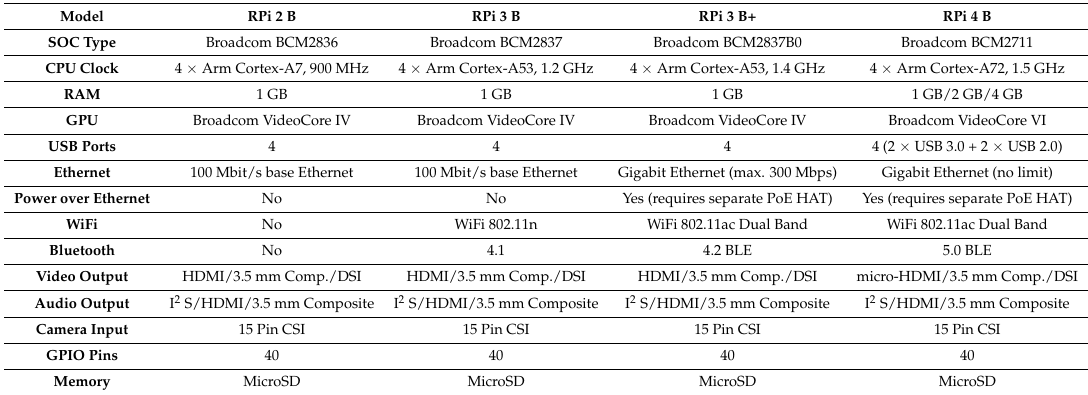
Table 1. Raspberry Pi (RPi) comparison